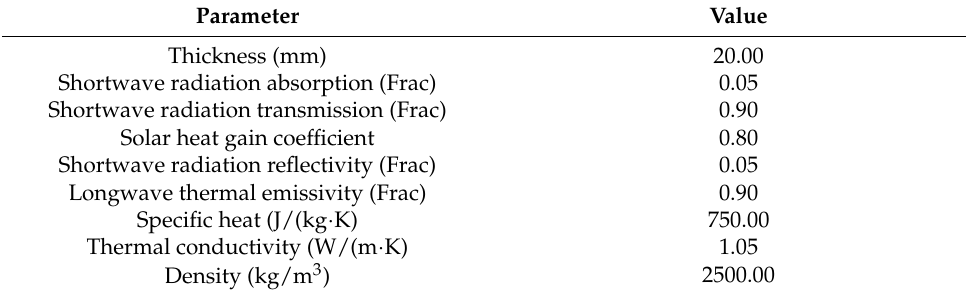
Table 3. Attributes of clear float